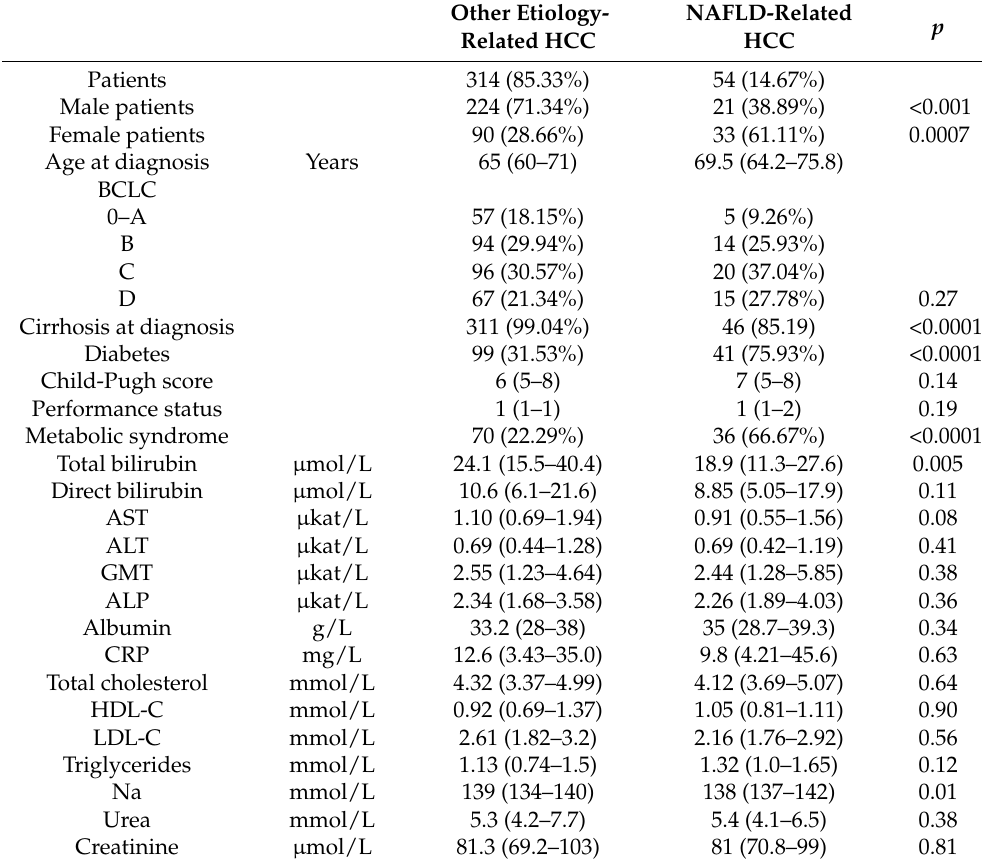
Table 1. Clinical and demographic characteristics of patients with